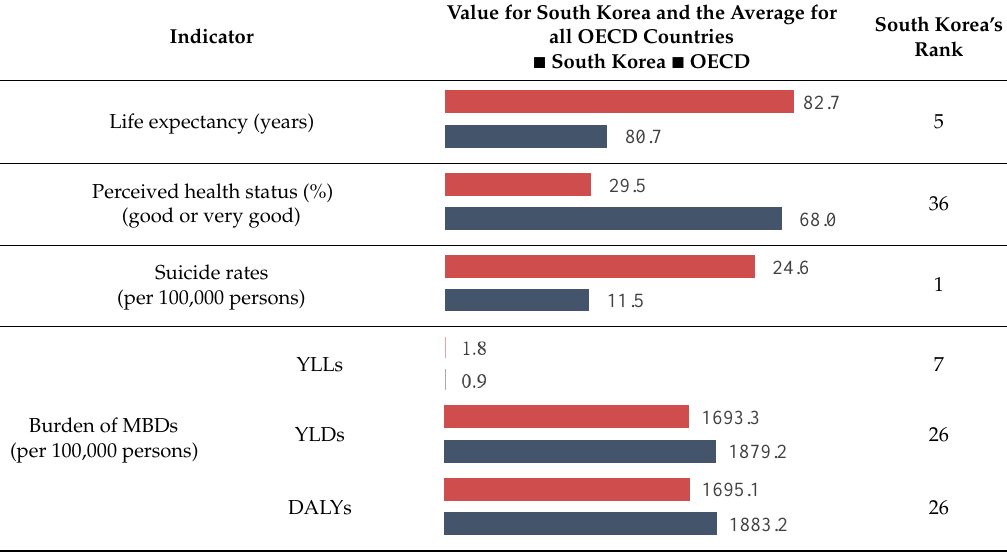
Table 1. Comparison of mental health indicators for South Korea with the Organization for Economic Cooperation and Development (OECD) average.